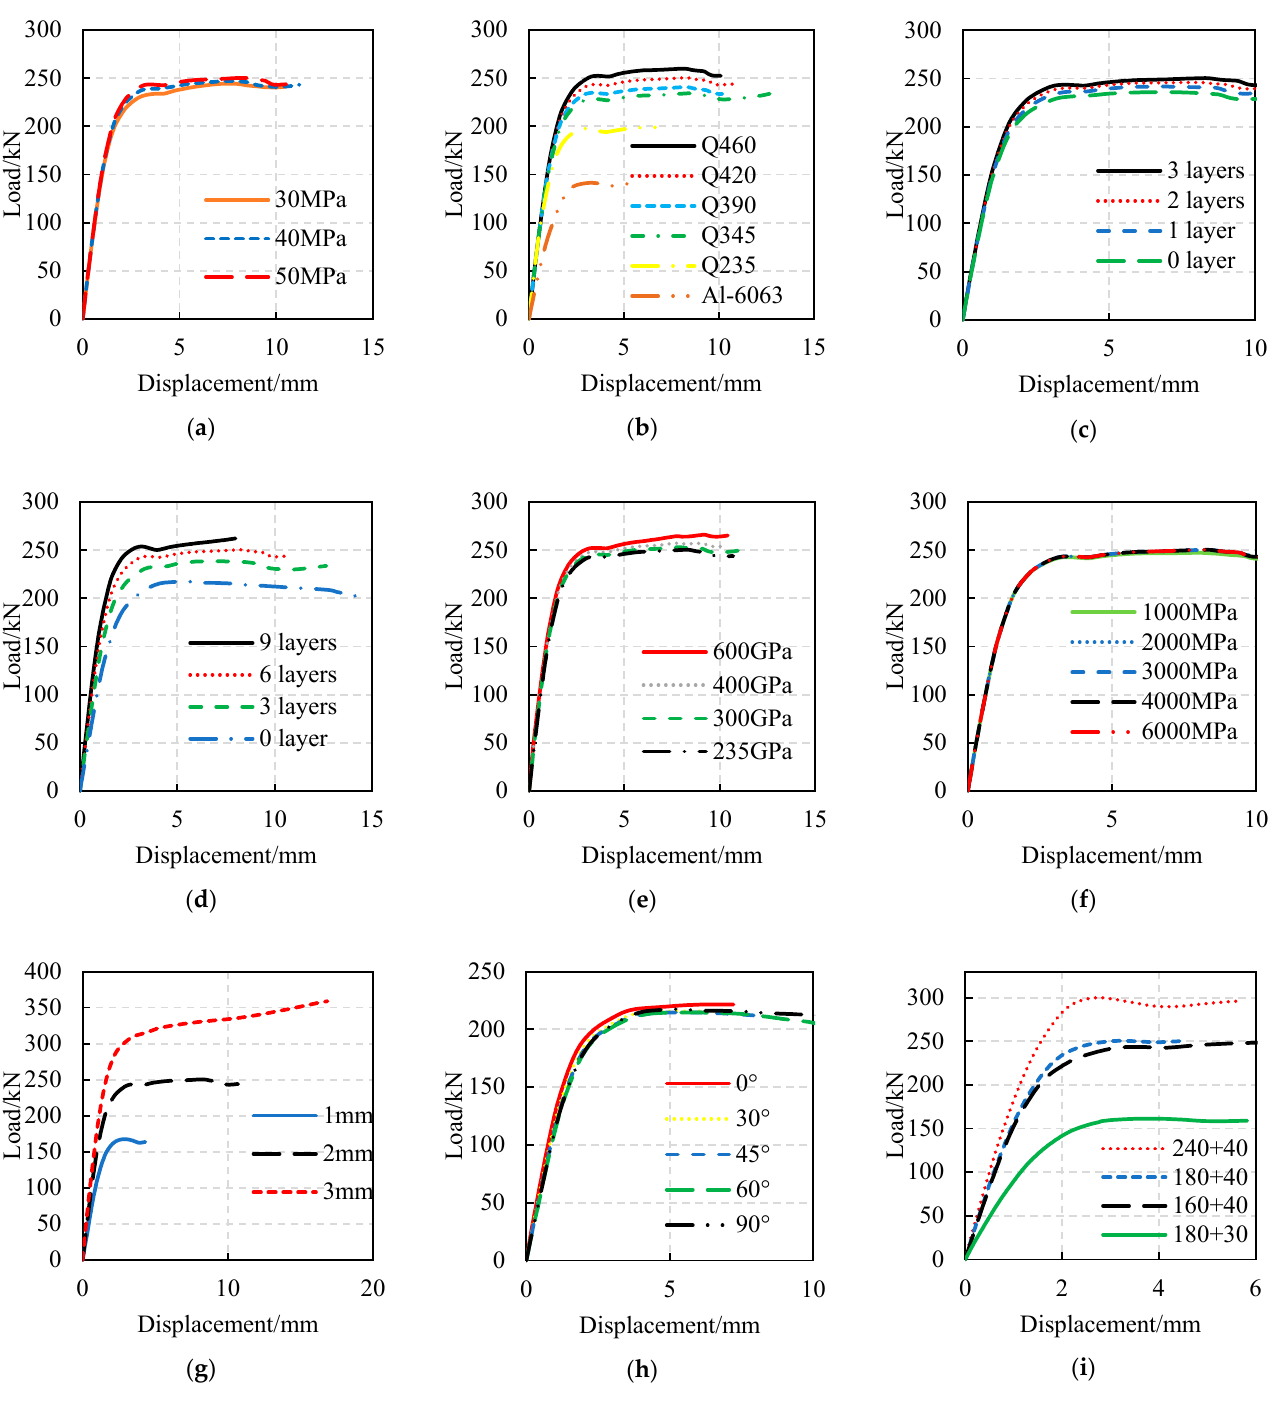
Figure 11. Parameter analysis of bending tests: ( a ) Variable is concrete strength. ( b ) Variable is steel grade. ( c ) Variable is the number of 0° CFRP layers. ( d ) Variable is the number of 90° CFRP layers. ( e ) Variable is the elastic modulus of CFRP. ( f ) Variable is the ultimate tensile strength of CFRP. ( g ) Variable is the thickness of the steel tubes. ( h ) Variable is the angle of the CFRP. ( i ) Variable is the section size of the FWP.